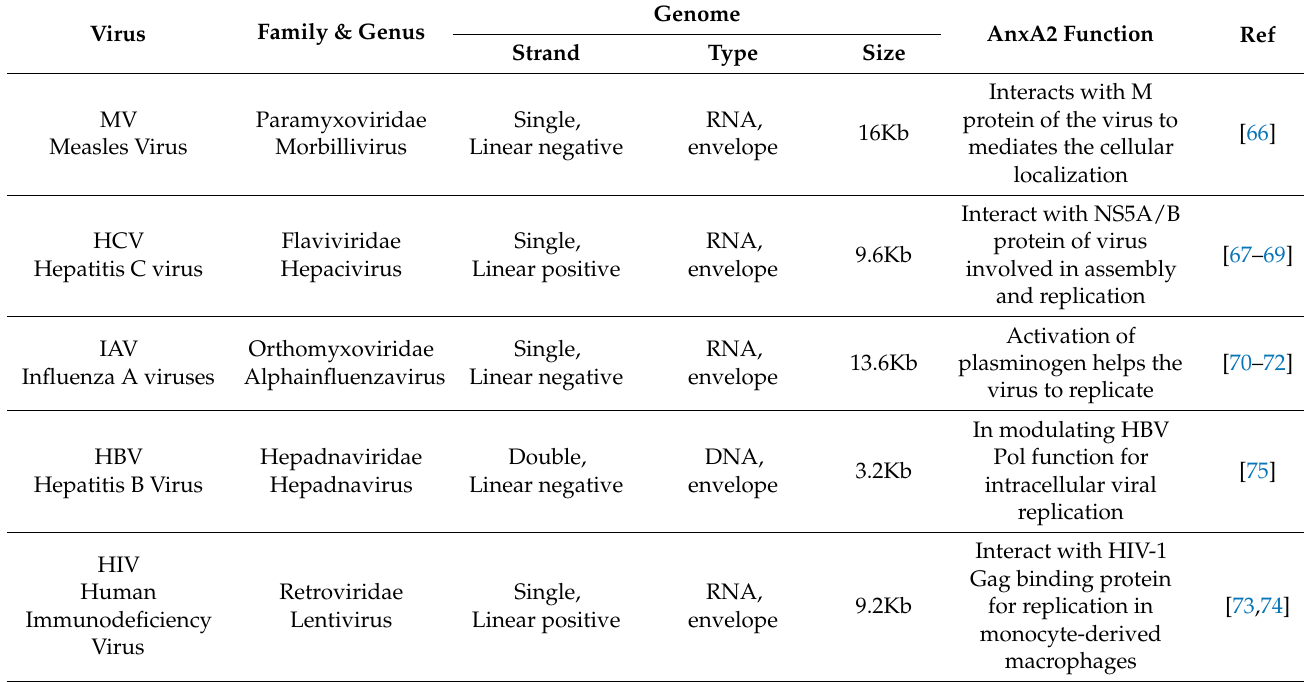
Table 2. The viruses interacting with AnxA2 for their replication, trafficking and release out of cell.